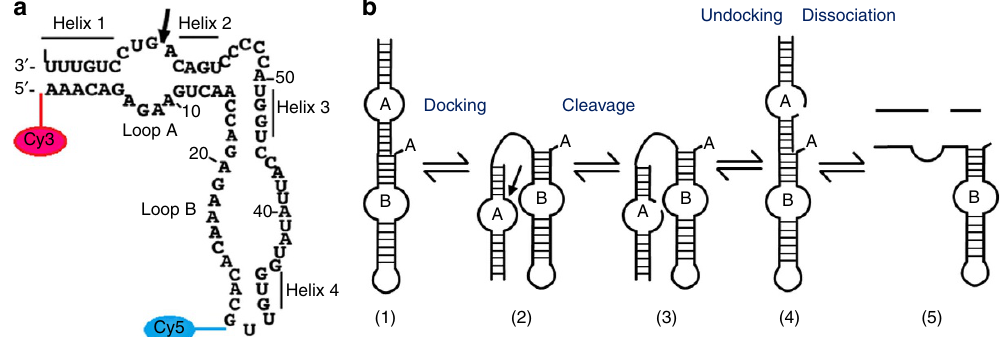
Figure 1 | Hairpin ribozyme and schematic representation of different stages in its catalysis. ( a ) Secondary structure of the FRET-labelled minimal wild- type self-cleaving hairpin ribozyme (HpRz) from tobacco ringspot virus satellite. The self-cleavage site is marked by an arrow 25 . ( b ) Schematic representation (scheme based on refs 23, 26) of the entire multistep self-cleavage process of HpRz involving non-covalent steps before and after the covalent self-cleavage reaction (that is, transesterification of the phosphodiester bond) from (2) to (3) as detailed in Fig. 2; note that all structures might still consist of different conformational substates, and all steps have been found to be